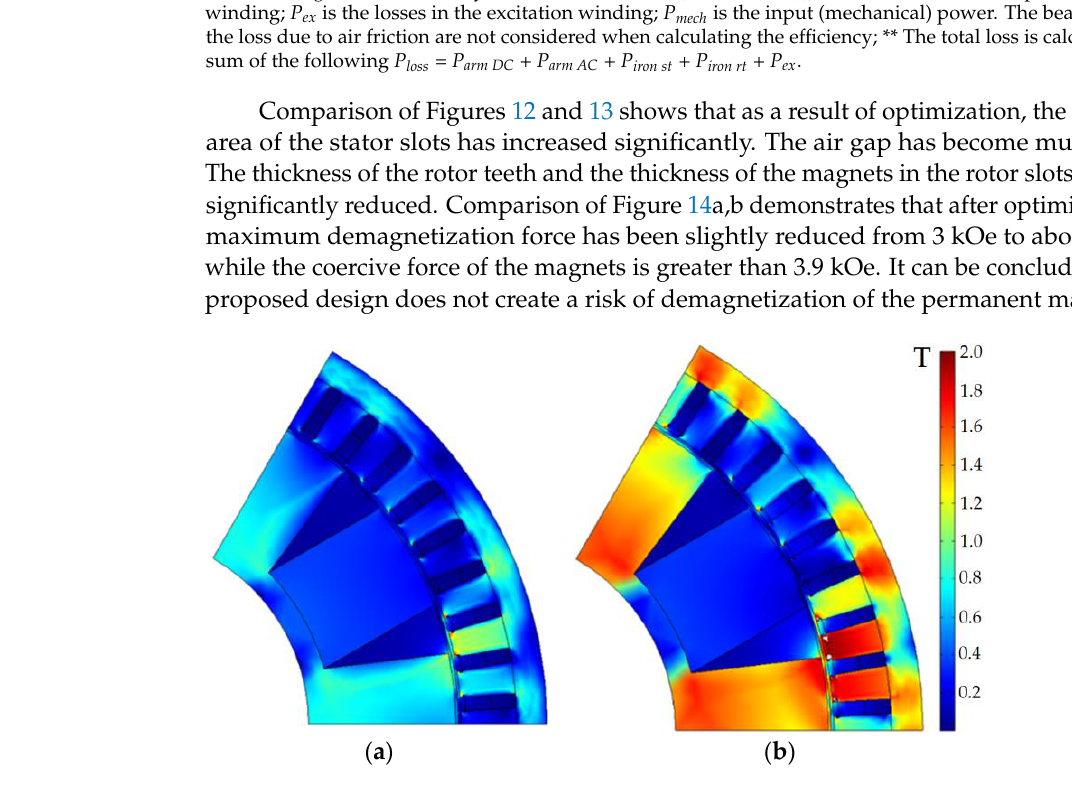
Figure 12. Pole-sector geometry of the generator for the initial design. White color shows areas with flux density more than 2 T: ( a ) Maximum speed; ( b ) Maximum